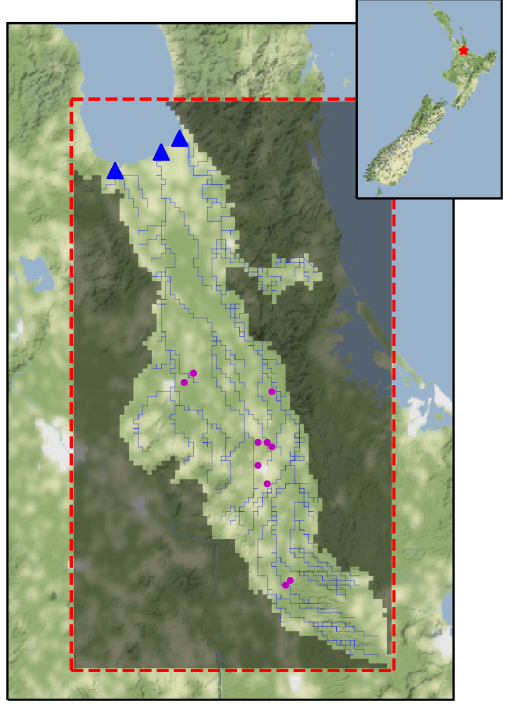
Figure 3. Hauraki Plains model extent (red dashed line), layer-one inactive area (shaded) and surface-water network (blue lines). The terminal surface-water reaches that discharge to the Firth of Thames are shown as blue triangles. The location of groundwater tritium measurements are shown as magenta